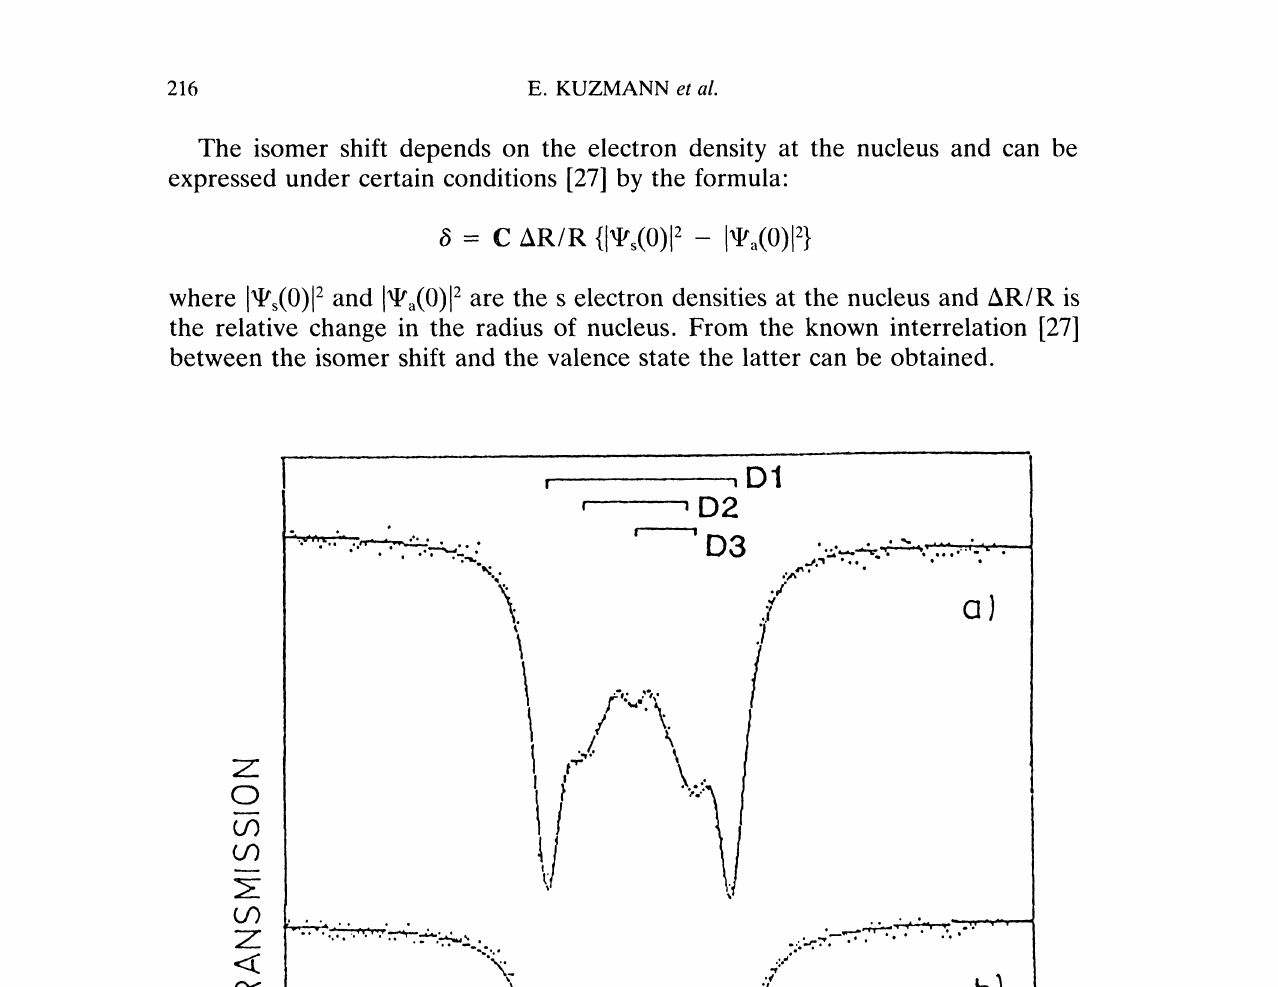
FIGURE 5 -TFe MOssbauer spectra of BaCuo.9STFeooO_ precursor (a) and EuBa(CuougSTFeoo03OT_a superconductor